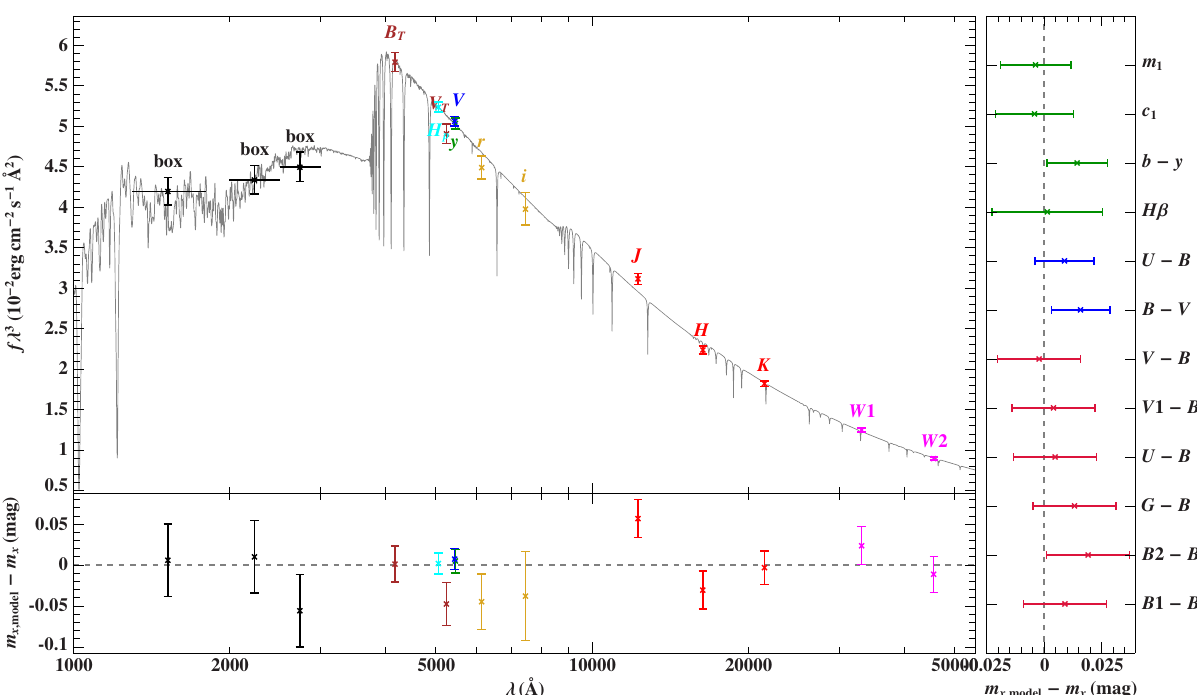
Figure 6. HD205805: Fit of the SED (top panel) simultaneously with available colours. Residuals are shown in the right hand (colours) and lower (fluxes) panels as magnitudes.